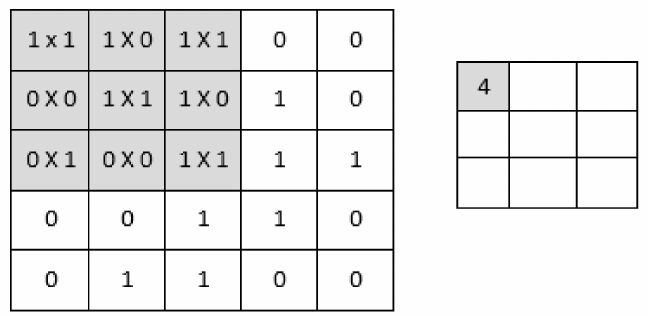
Figure 5. Calculation of filter slides over input image